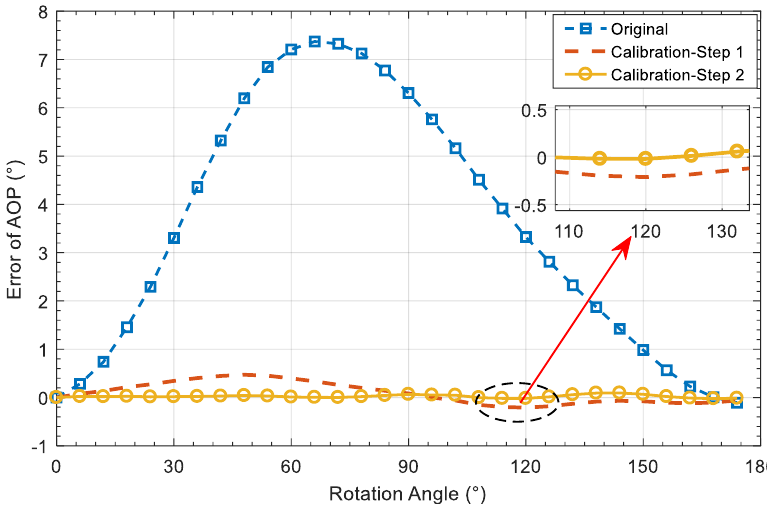
Figure 8. ( a ) AOP accuracy after calibration under different polarized light-intensity levels; ( b ) Comparison of SD of AOP error before and after calibration. Figure 9. Comparison of AOP error before and after calibration.